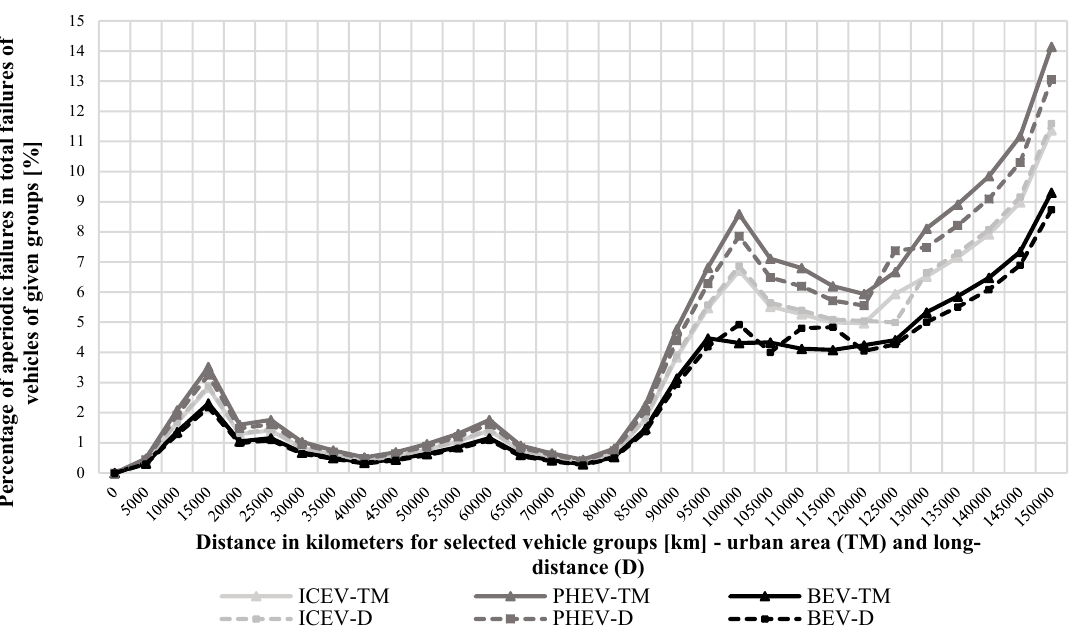
Figure 9. Distribution of aperiodic failures for a sport utility vehicle with ICEV, PHEV, and BEV propulsion for urban and long-distance speed profiles over a distance of 150,000 km.